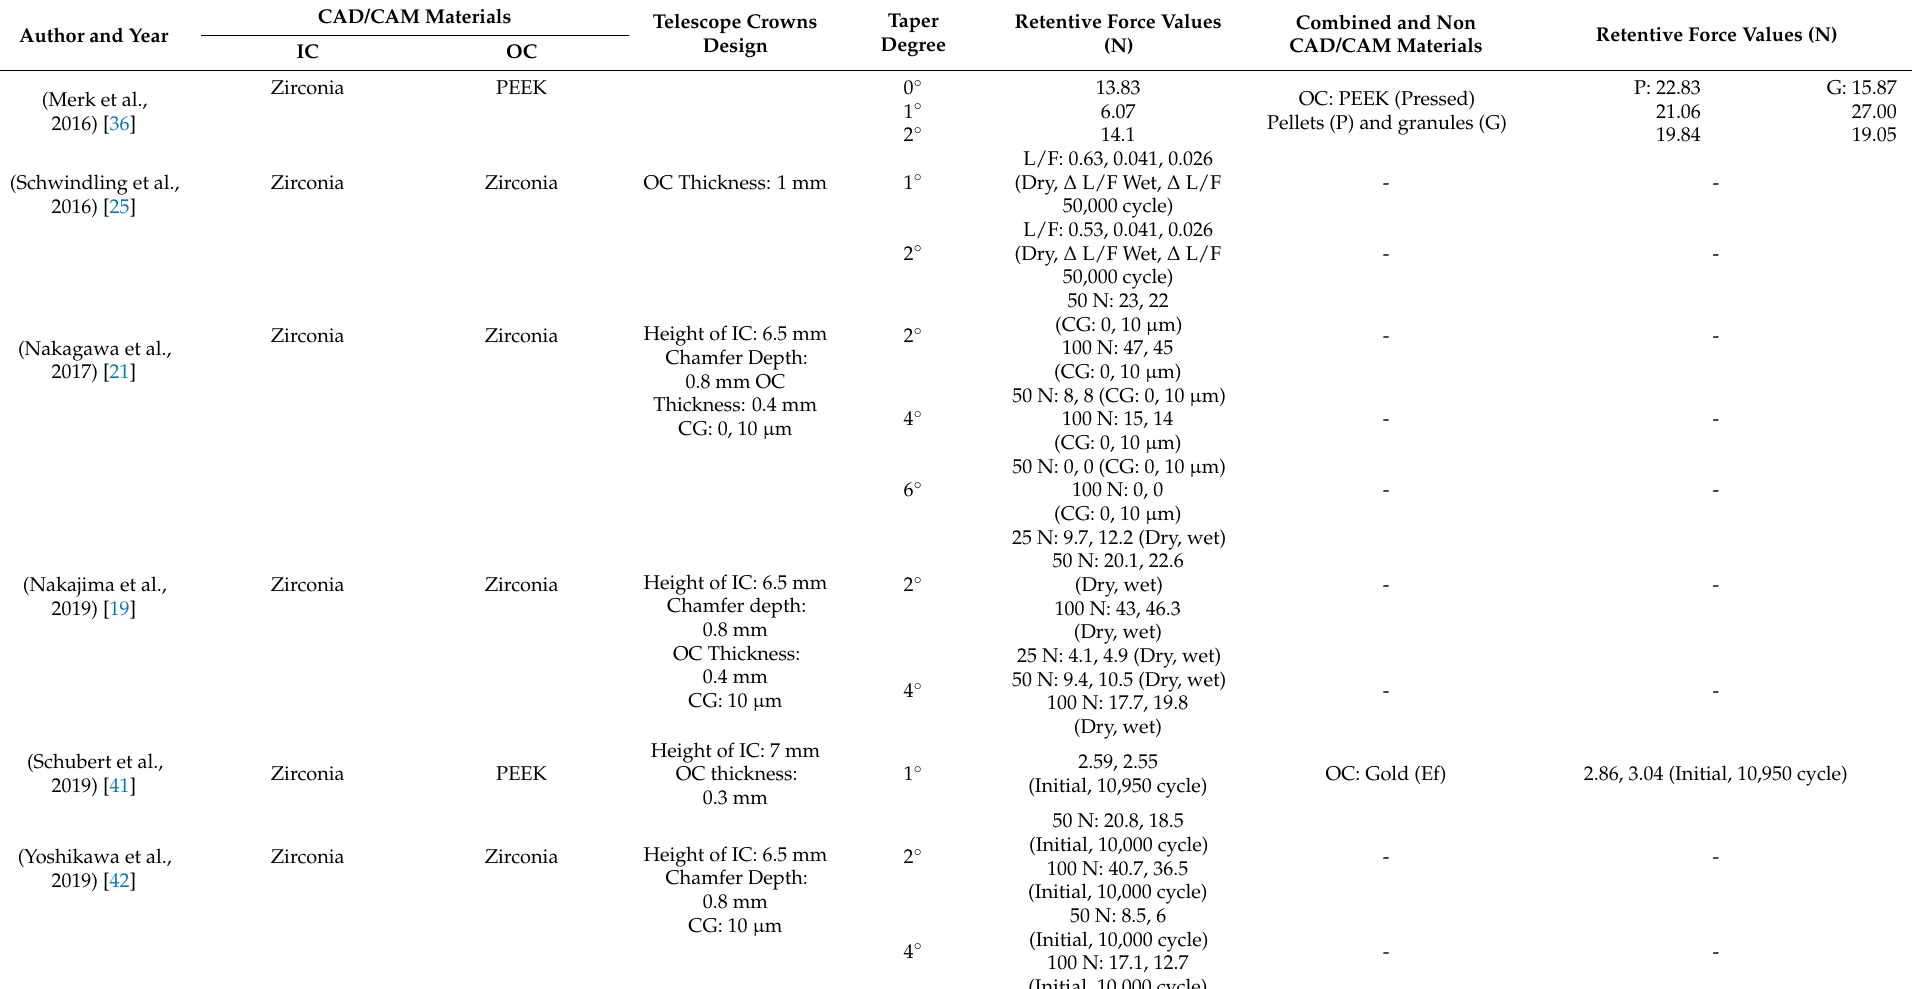
Table 2. Design features of telescope crowns used in each study and retentive force values recorded with each parameter in CAD/CAM groups and other reference